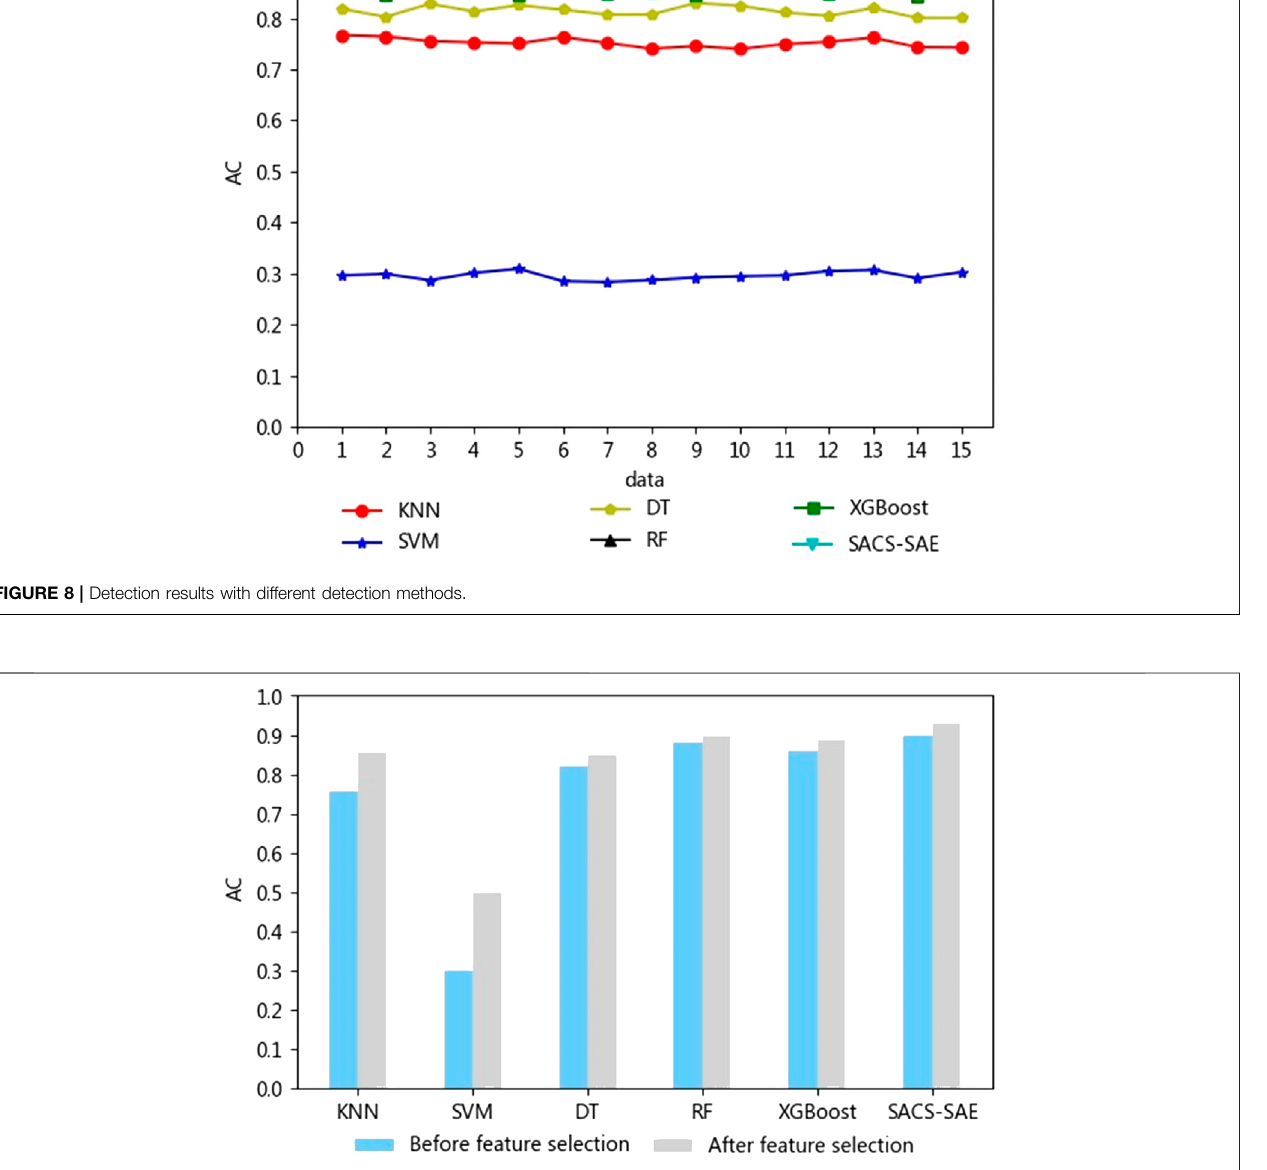
FIGURE 9 | The in fl uence of attack gene feature selection with different